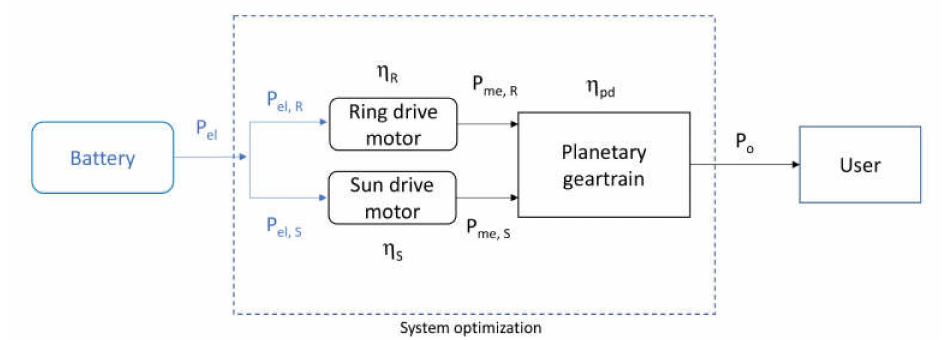
Figure 3. Block diagram describing the power flow of the dual-motor powertrain.